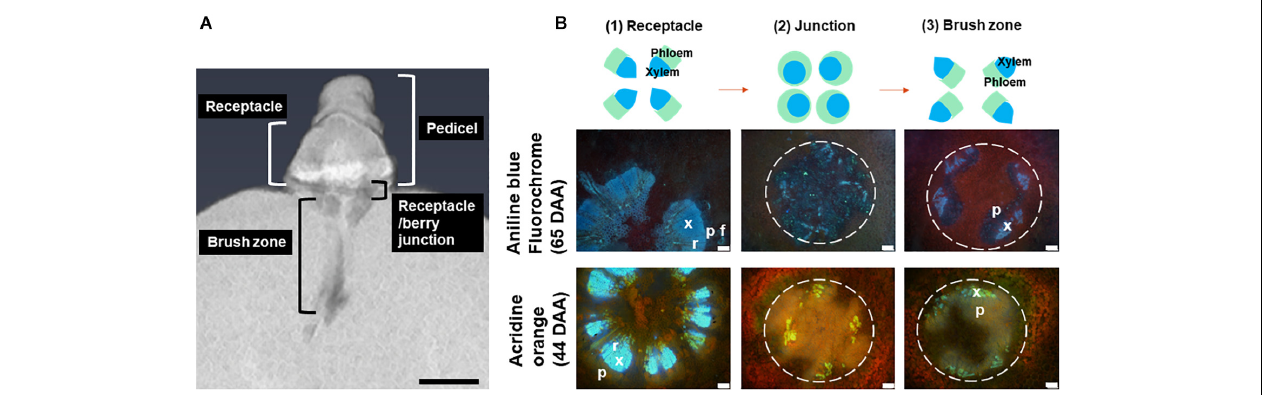
FIGURE 3 | A longitudinal section of a 3D berry reconstructed using micro-CT, showing the locular cavity/vascular connection from the pedicel to the berry. Scale bar = 1 mm (A) . A schematic drawing of change in central vascular bundles xylem and phloem arrangement in three positions including the receptacle (1), junction (0–2 mm from receptacle/berry junction) (2) and the brush zone (2–6 mm from the junction) (3) and image examples of aniline blue fluorochrome and acridine orange stained Sauvignon Blanc (white dashed circles indicate central vascular bundles; x, xylem; p, phloem; r, xylem ray; f, phloem fiber). Excitation filter 330–385 nm,